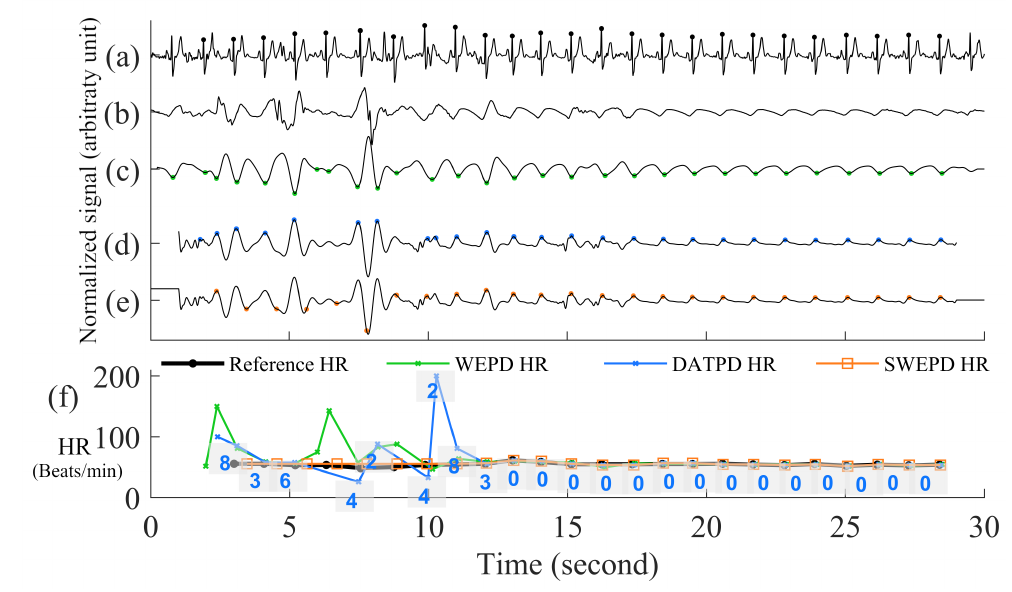
Figure 8. Representative example of the peak correction for NSR. Top panel ( a ) is the reference ECG; panel ( b ) is the raw PPG signal; panel ( c ) is the peak detection output from WEPD; panel ( d ) is the peak detection from DATPD; panel ( e ) is the SWEPD peak correction for NSR with corrected heartbeats (unit: BPM). The bottom panel ( f ) is the heart rate comparison with the reference heart rate, estimated heart rates from WEPD, DATPD, and SWEPD. Region information for each heartbeat of DATPD method is labeled on the heart rate in the bottom panel ( f